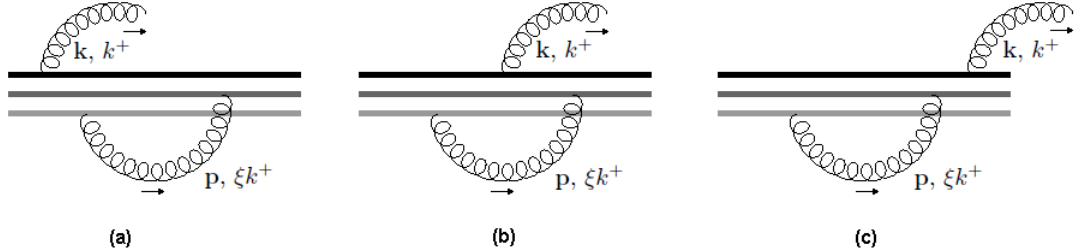
(cid:12) (cid:12) (cid:11) (cid:11) , (c) - . (cid:12) 7 g (cid:12) 8 g